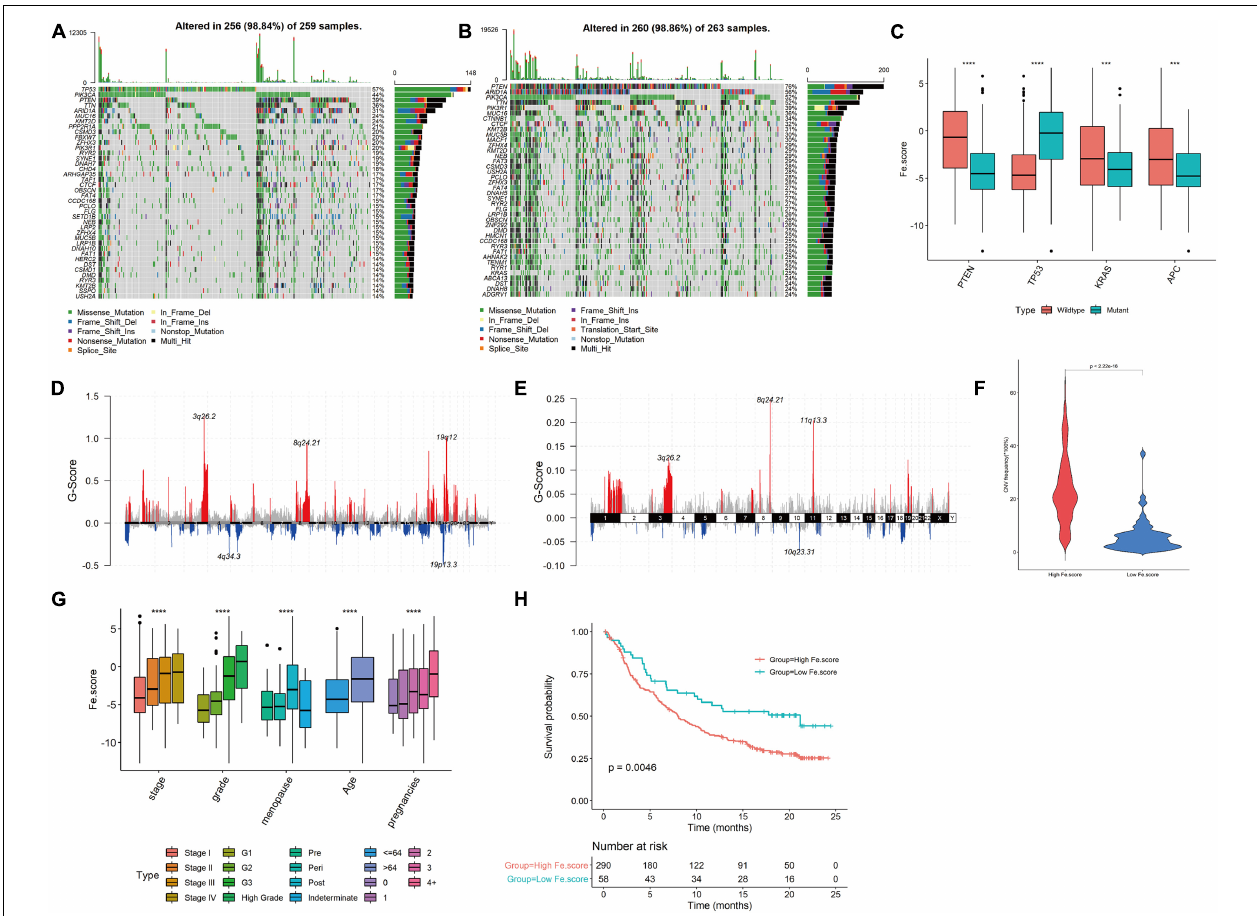
FIGURE 7 | Correlation between ferroptosis score and clinical characteristics. (A) Somatic mutation spectrum of the high-Fe.score group. (B) Somatic mutation spectrum of the low-Fe.score group. (C) Correlation between PTEN, TP53, KRAS, APC mutation, and Fe.score. (D) CNV peak map of the high-Fe.score group. (E) CNV peak map of the low-Fe.score group. The difference in Fe.score for each clinical indicator (stage, grade, menopausal status, age, and fertility status) in endometrial cancer samples. (H) Kaplan–Meier survival curve of Fe.score. (F) Violin chart of CNV mutation frequency in High Fe.score group and Low Fe.score group. (G) The difference of Fe.score in clinical indicators in EC samples. *** p < 0.001 and **** p <